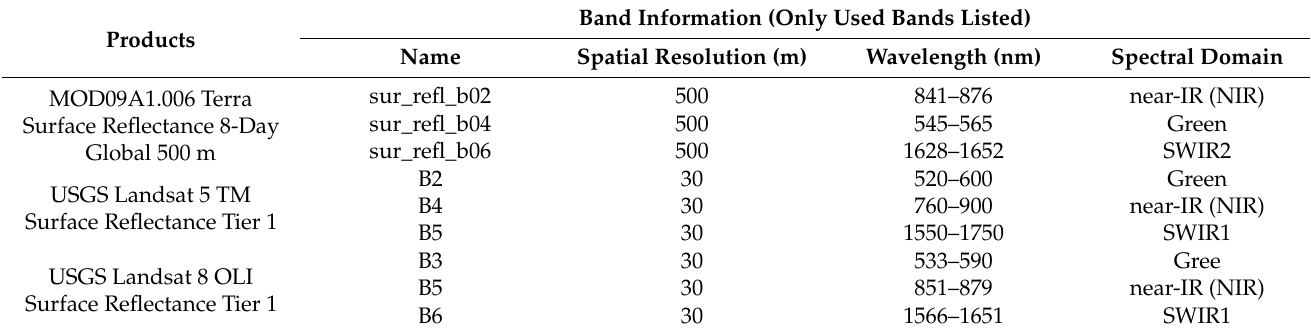
Table 1. Overview of applied satellite data on surface reflectance.